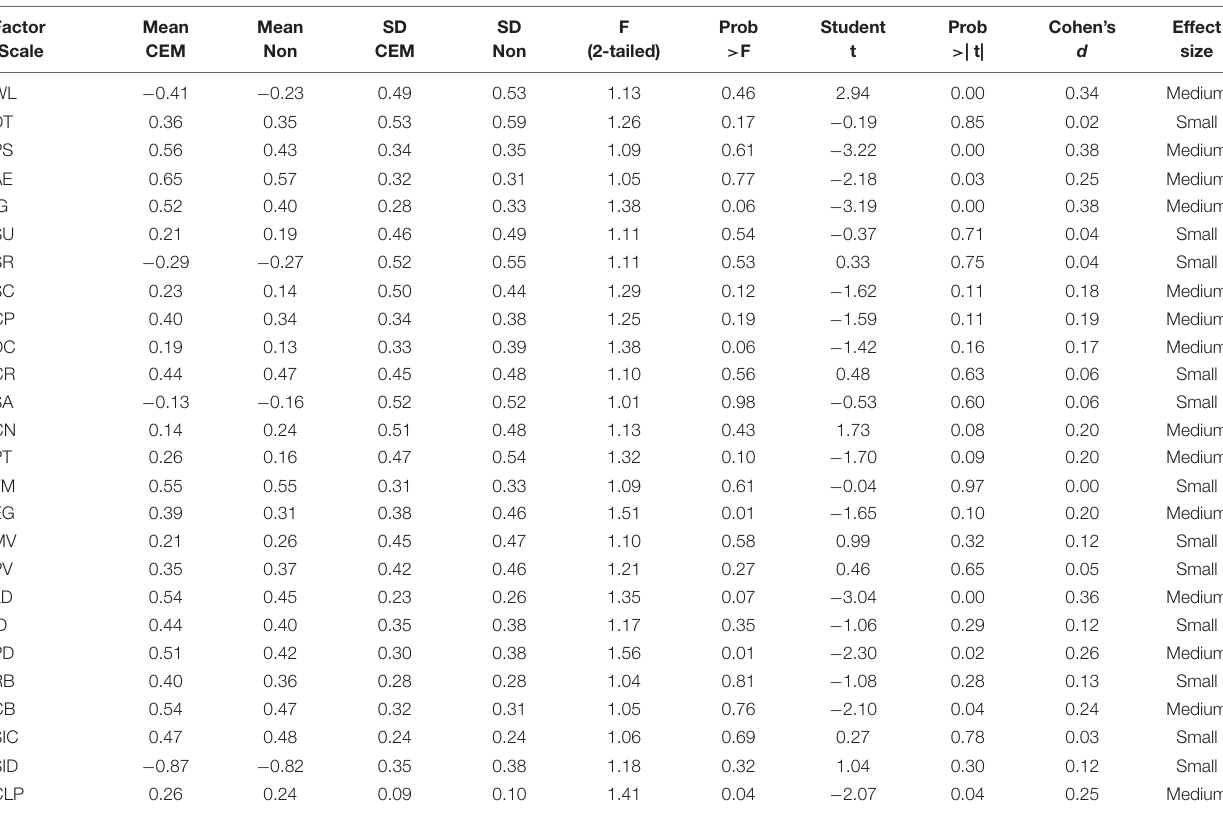
TABLE 5 | Differences in MMP scale scores between certified (CEM) and non-certified (Non) emergency managers ( n CEM =114; n Non =215). Factor /Scale